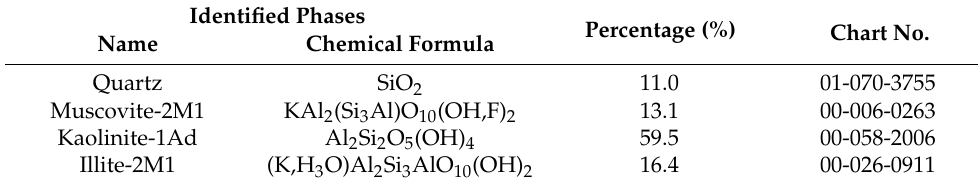
Figure 3. XRD analysis for coal shale from Marcel mining (before calcination). Table 3. Phases identified along with their percentage share in the sample.